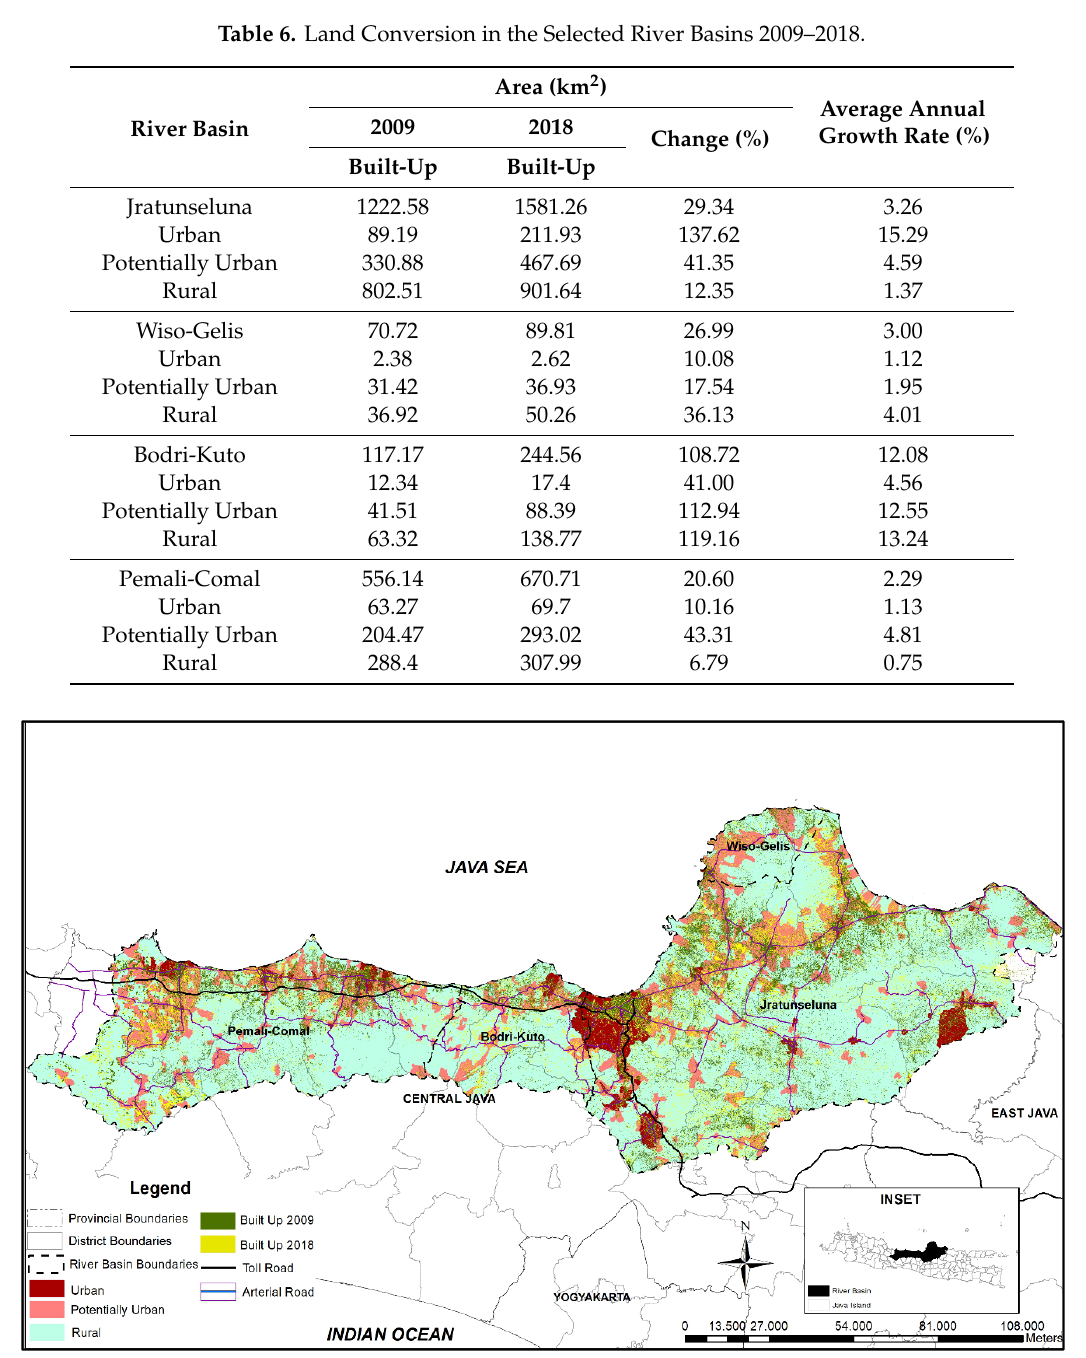
Figure 4. Land Conversion, 2009–2018.